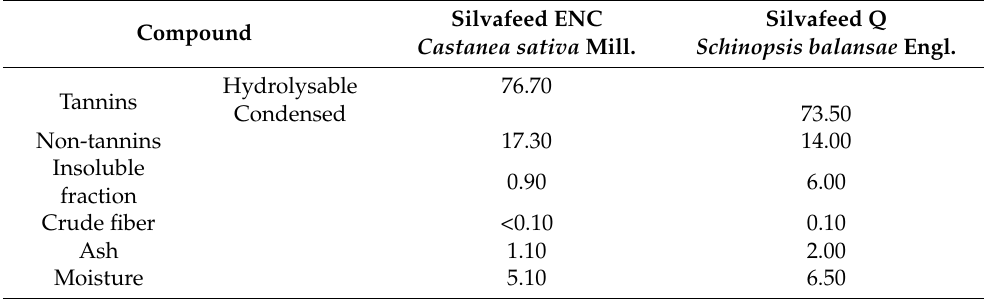
Table 1. Composition of studied extracts ( w / w ).